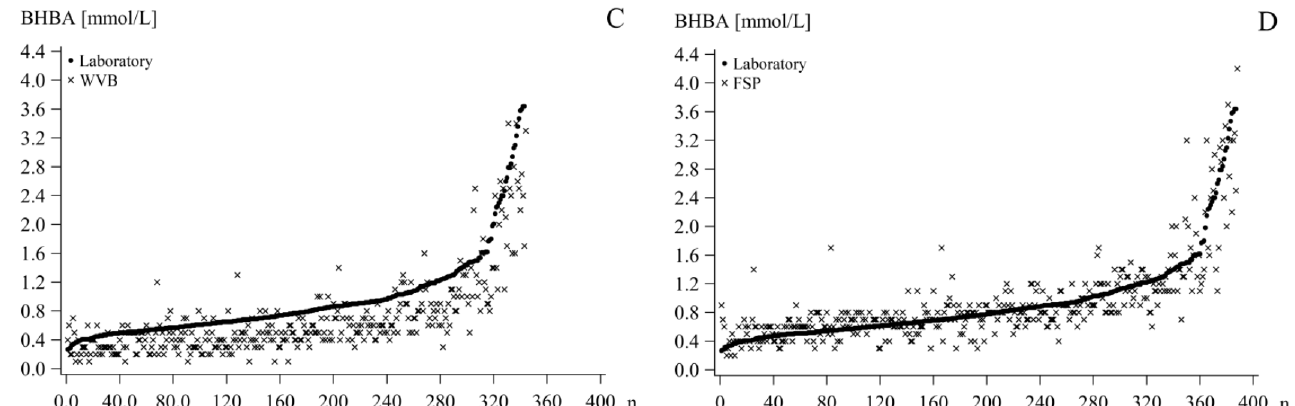
Figure 1. Distribution of BHBA measured with TD 1 ( A ), GLP 1 ( B ), WVB 1 ( C ), and FSP 1 ( D ) in coccygeal whole blood (symbol: × ) compared to the reference method, BHBA in serum (symbol: circle filled), which is sorted in ascending order. On the x -axis, the number of sample pairs (n) of BHBA LAB and BHBA TD/GLP/WVB/FSP are displayed. 1 TD = BHB- Check (TaiDoc Technology Corporation, Taiwan, CHN); GLP = GlucoMen LX Plus (A. Menarini Diagnostics, Berlin, DE); WVB = WellionVet BELUA (MED TRUST GmbH, Ottendorf-Okrilla, DE); FSP = Freestyle Precision Neo (Abbott GmbH & Co. KG, Wiesbaden,